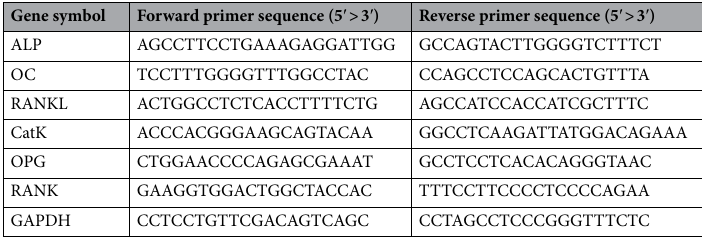
Table 1. Primer sequences for real time polymerase Chain